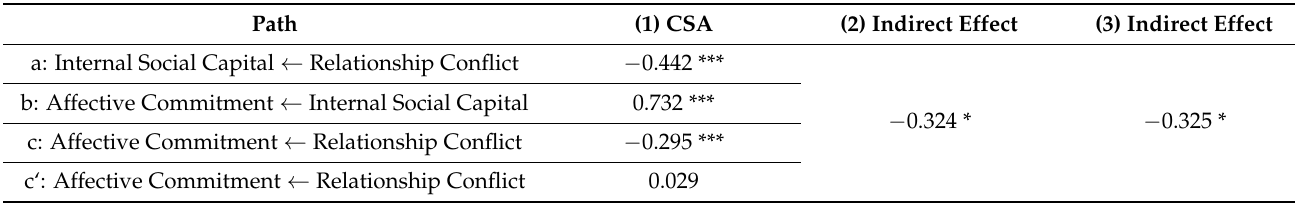
Table 7. Mediation results.